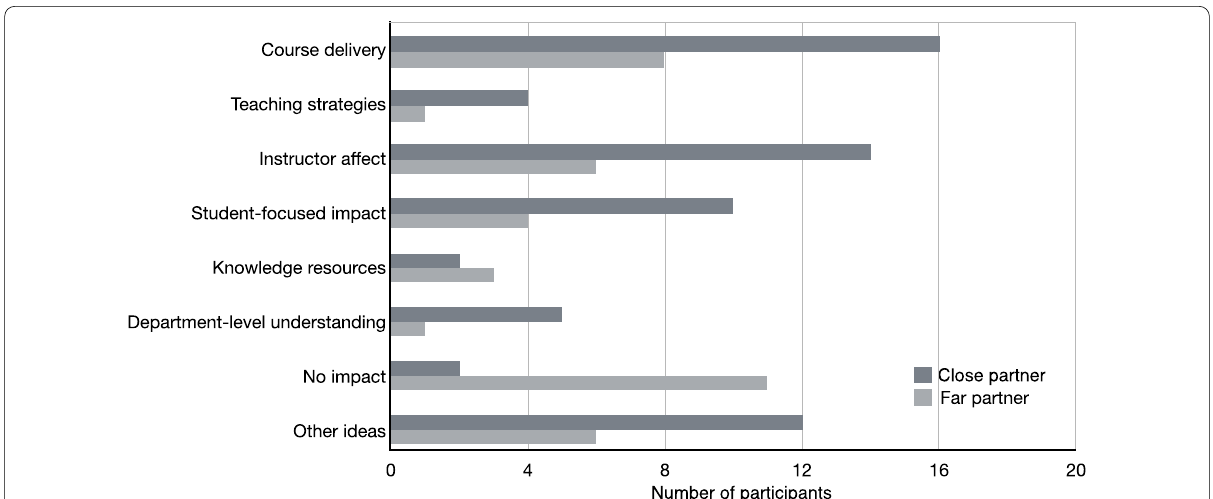
Fig. 5 Perceived impacts of teaching-related conversations. Bars represent the number of interview participants ( n close (dark gray) and far (light gray) partners included discussion and information sharing related to the given category. Discussion pairs could share more than one impact